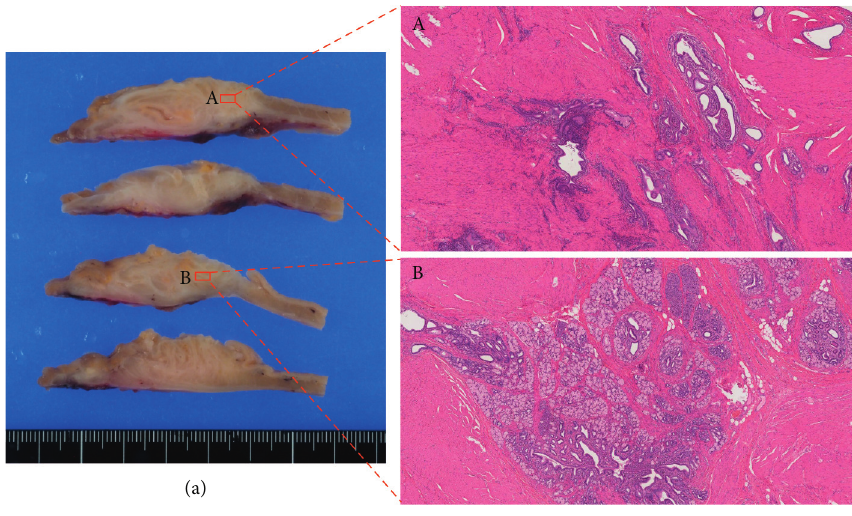
Figure 3: (a) Macroscopic findings. The resected specimen showed a vague nodule with dilated glands surrounded by edematous stroma in the submucosa and muscularis propria. (b) Histological findings. (A) Its appearance was similar to that of uterine adenomyosis. (B) The mass was composed of several types of glands, acini, and smooth muscle bundles.